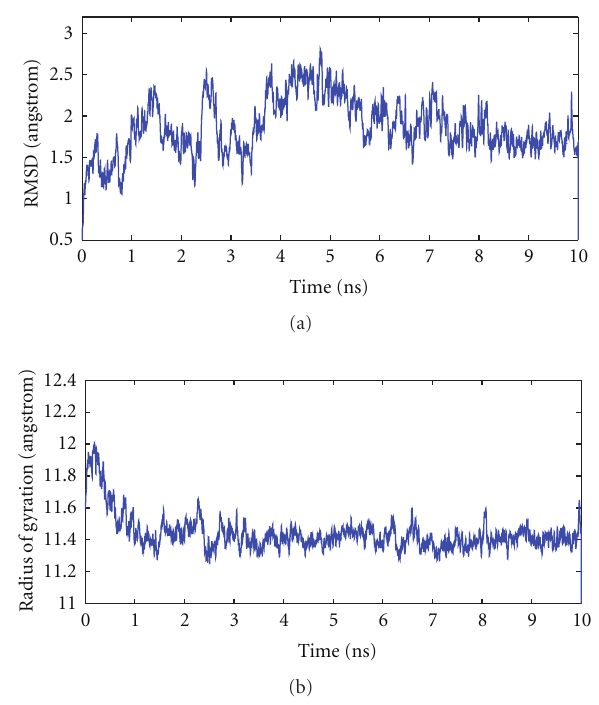
Figure 2: Structural drift of the protein ubiquitin in bulk water at 300 K during a 10 ns constant temperature and pressure simulation. Result of a single simulation run. (a) Root mean square deviation of C α backbone. (b) Radius of